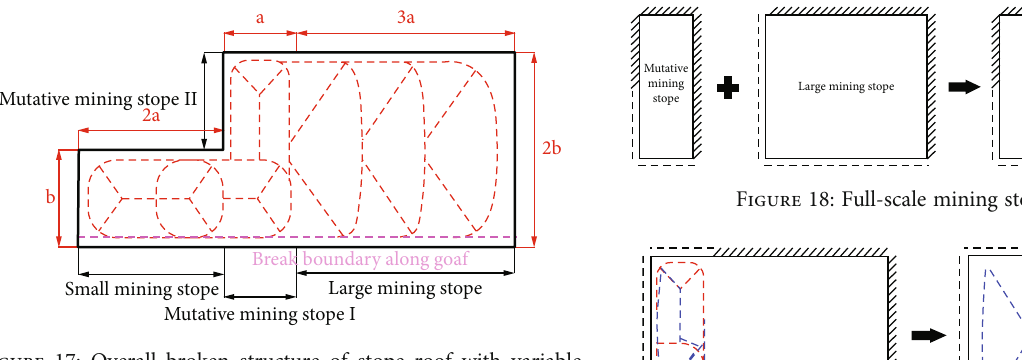
Figure 17: Overall broken structure of stope roof with variable